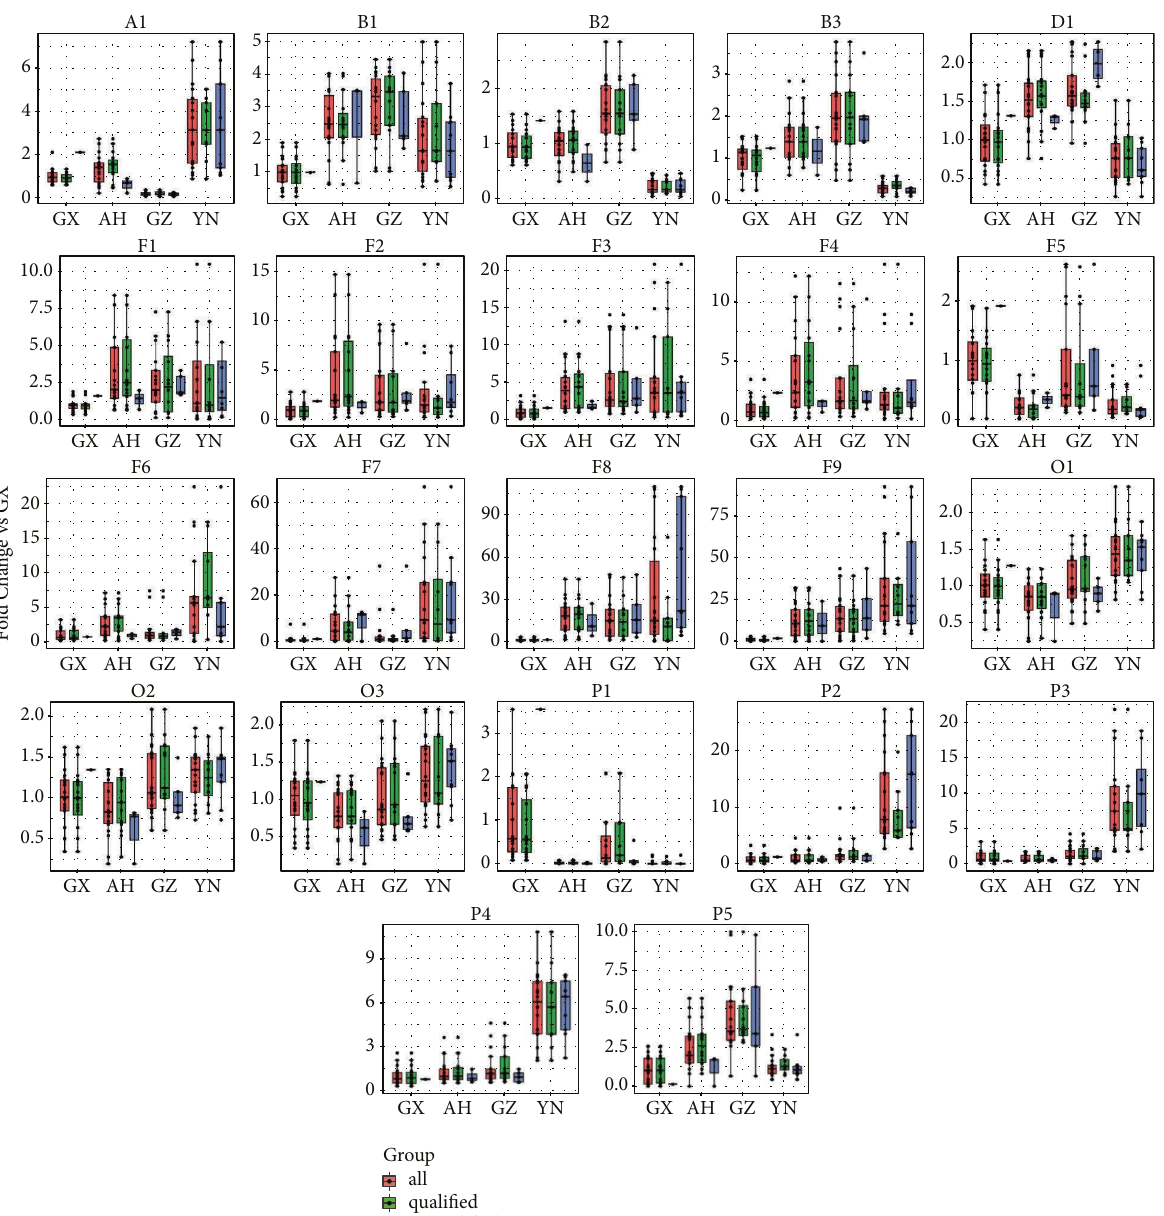
Figure 5: Expression of diferential compositions in D. ofcinale from four